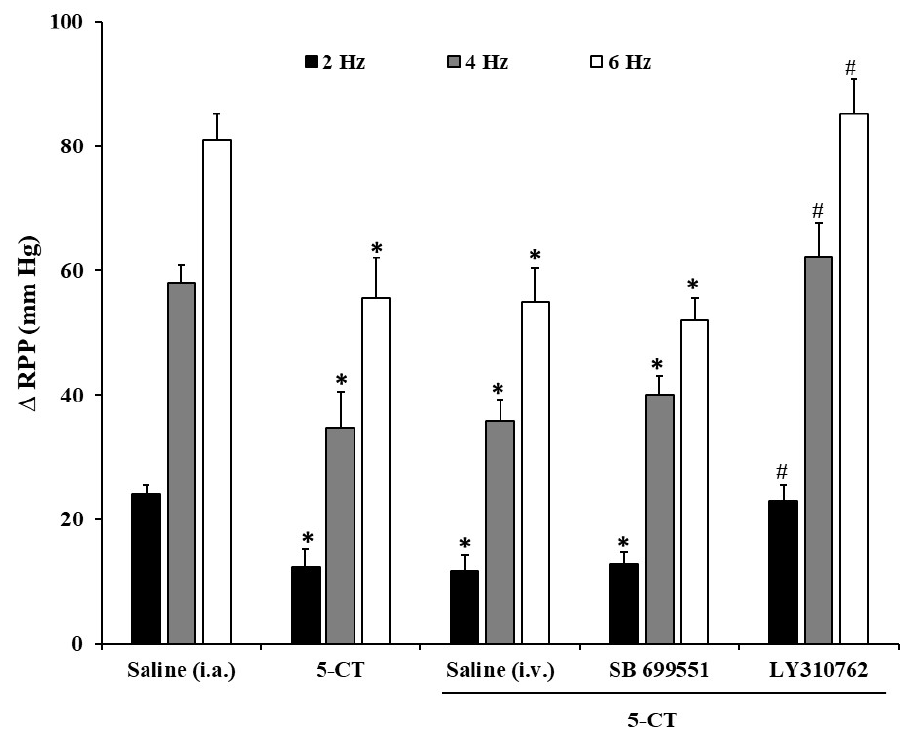
Figure 4. Effect of i.v. pretreatment of serotonergic receptor subtype antagonists on the 5-CT inhibitory effect of the renal sympathetic-induced vasopressor responses in diabetic rats. Effect of i.a. bolus of saline (10 μL) or 5-CT (0.4 μg/kg) in the absence or the presence of i.v. pretreatment with saline (1 mL/kg), SB 699551, or LY310762 (1 mg/kg each) on the vasopressor responses elicited by electrical stimulation of renal sympathetic nerves in diabetic rats. * p < 0.05 vs. saline i.a.; # p < 0.05 vs. 5-CT.